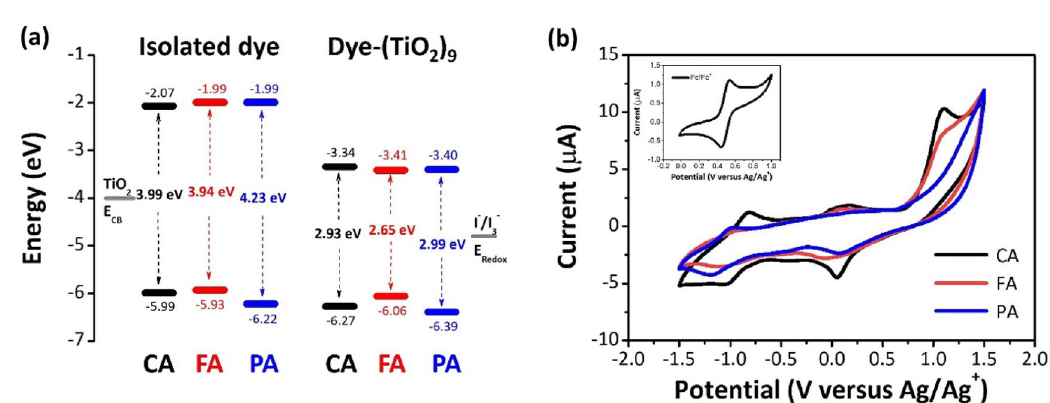
Figure 3. ( a ) Calculated energy levels of the HCA derivatives (PA, FA, CA) and HCA-grafted TiO 2 complexes and ( b ) cyclic voltammograms of the synthesized dyes in EtOH (1 mM) at a scan rate of 100 mV s −1 . Ferrocene/ ferrocenium (Fc/Fc + ) couple was used as an external reference (Inset).